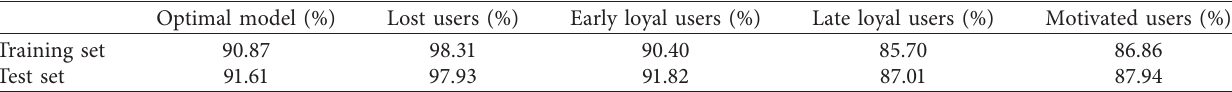
Table 7: Prediction accuracy of various users under the optimal